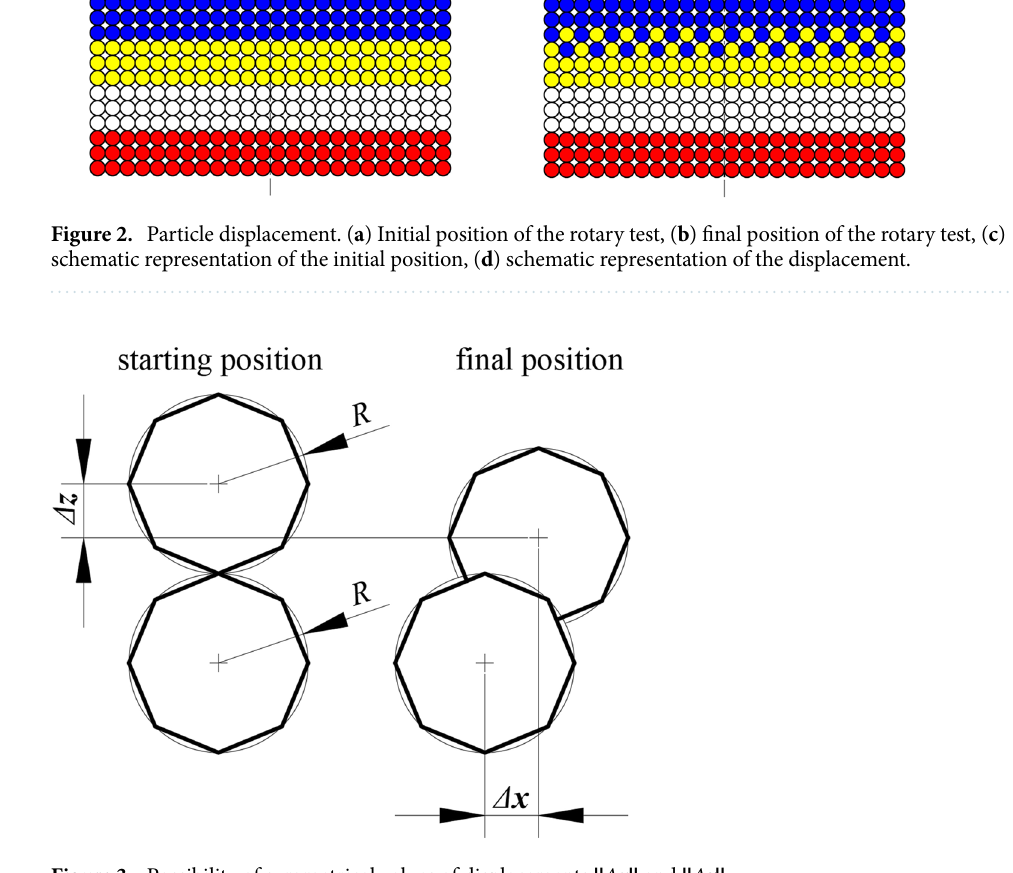
Figure 3. Possibility of symmetrical values of displacements ǀǀ Δ x ǀǀ and ǀǀ Δ z ǀǀ